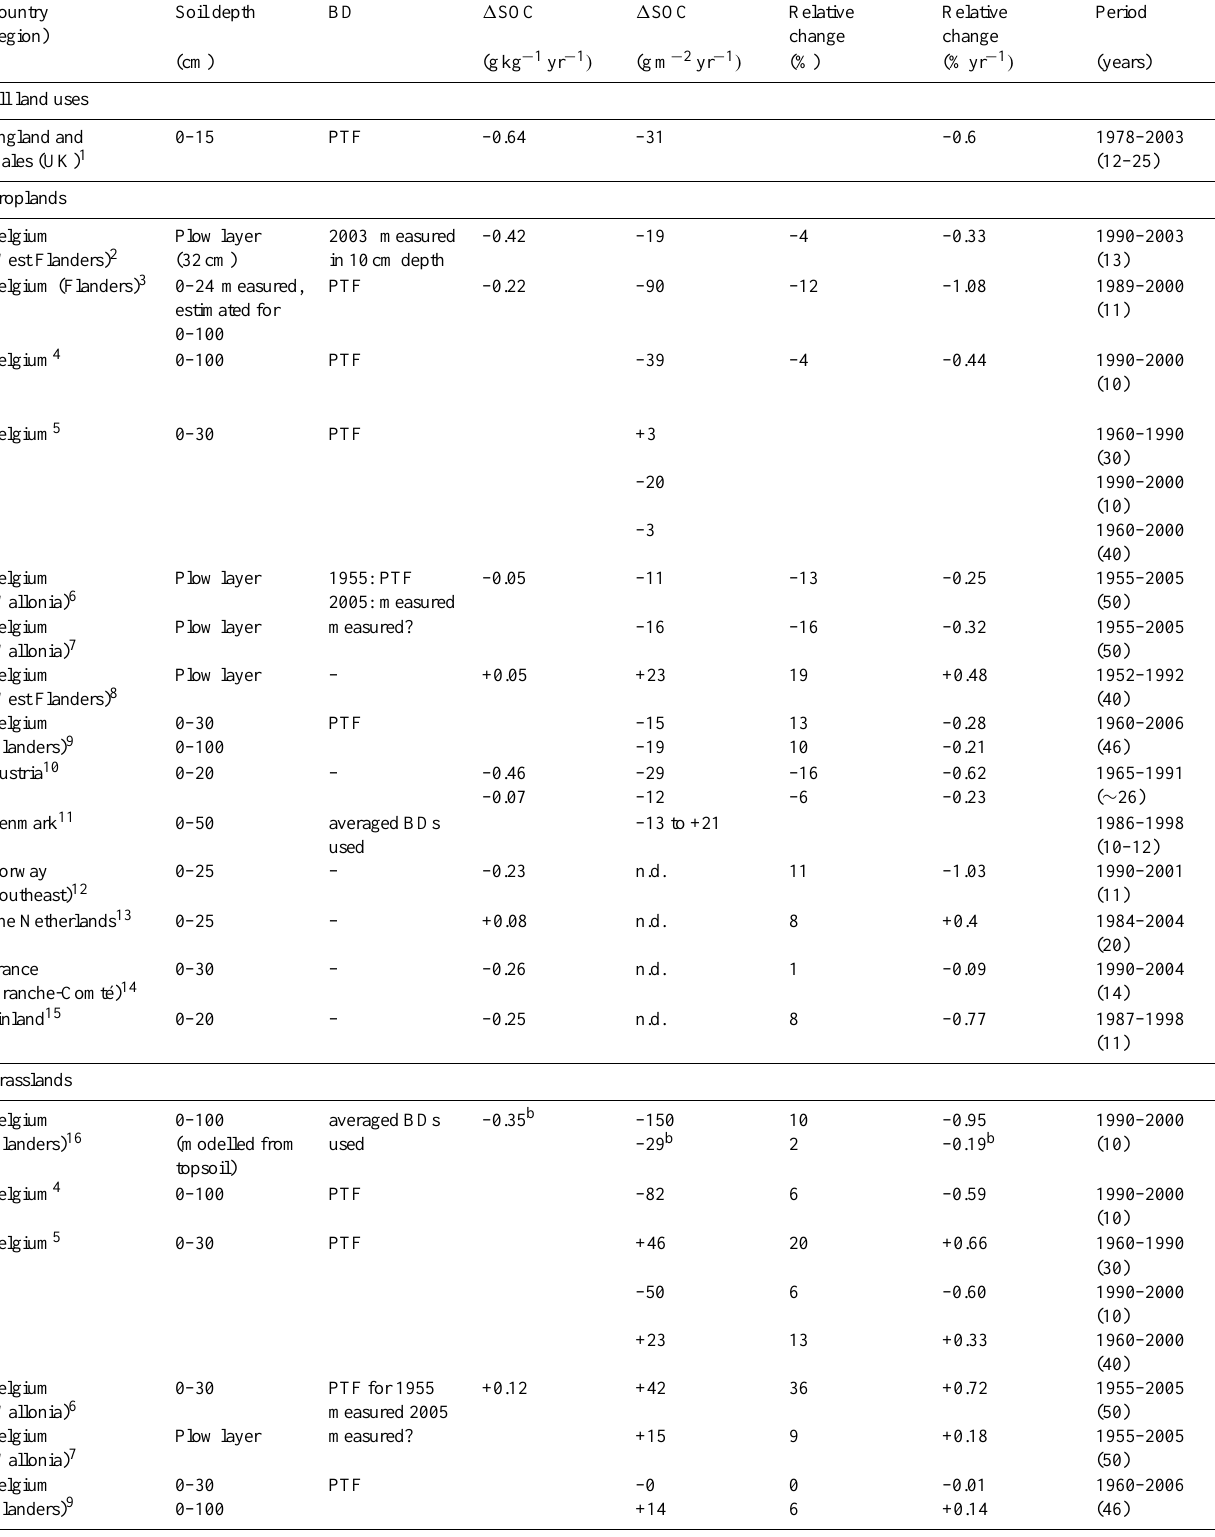
Table 1. Summary of European studies on changes in soil organic carbon by repeated soil inventories at the regional